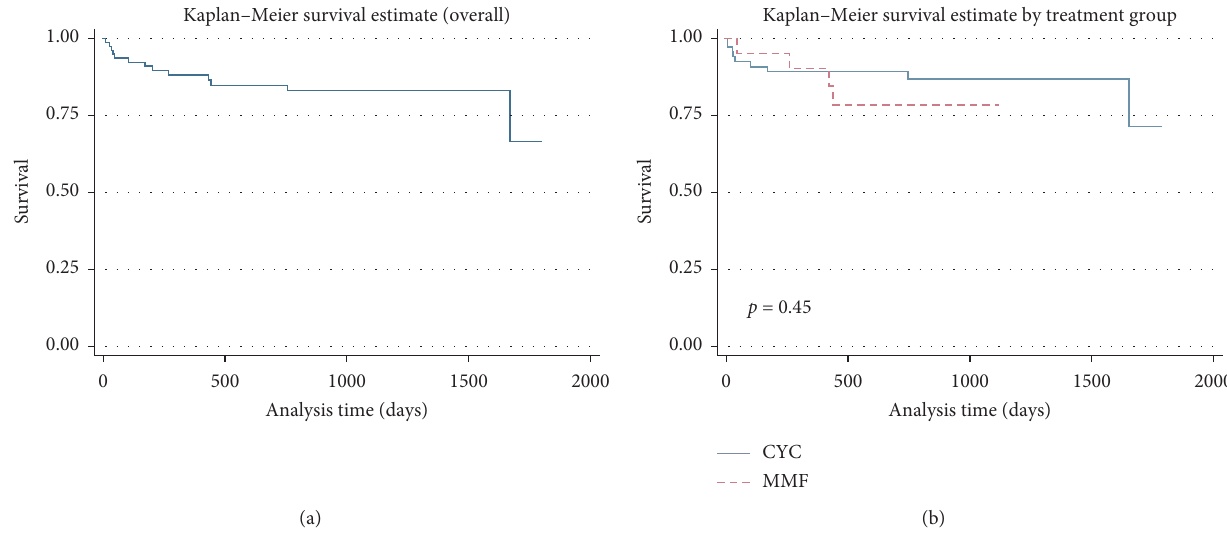
Figure 2: (a) Overall survival and (b) survival comparison between the IVCYC and MMF